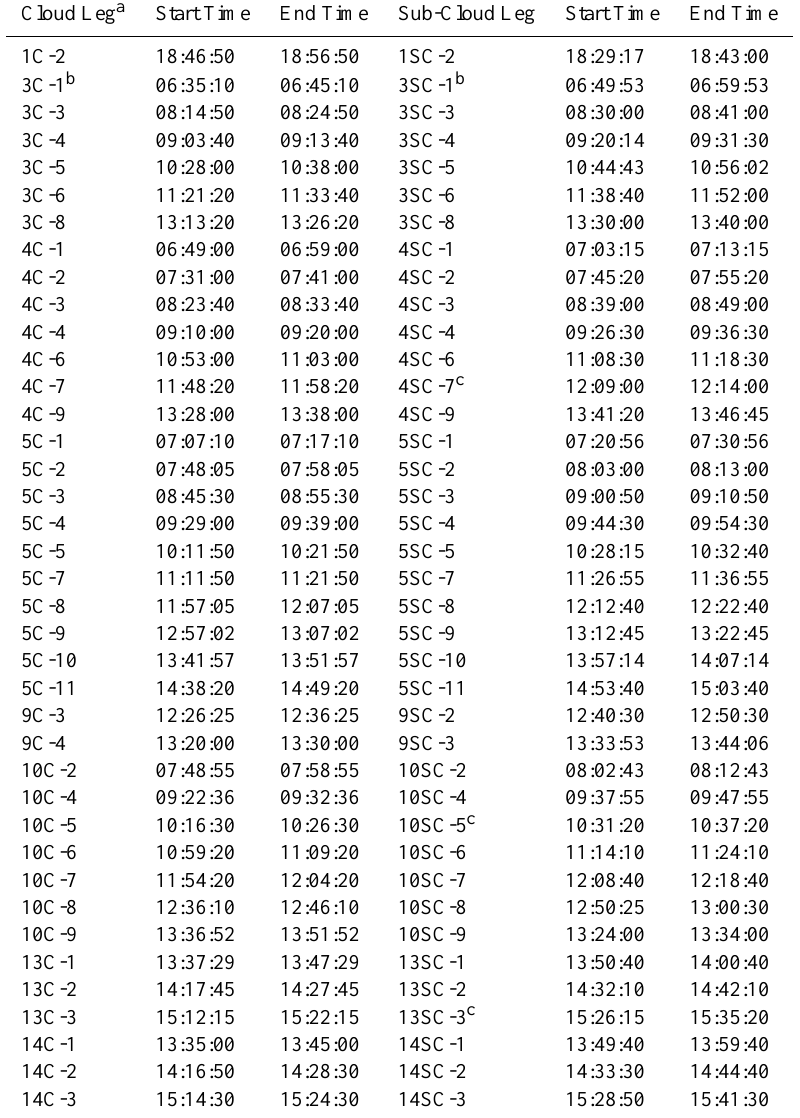
Table 1. Cloud and sub-cloud leg times (UTC) used in